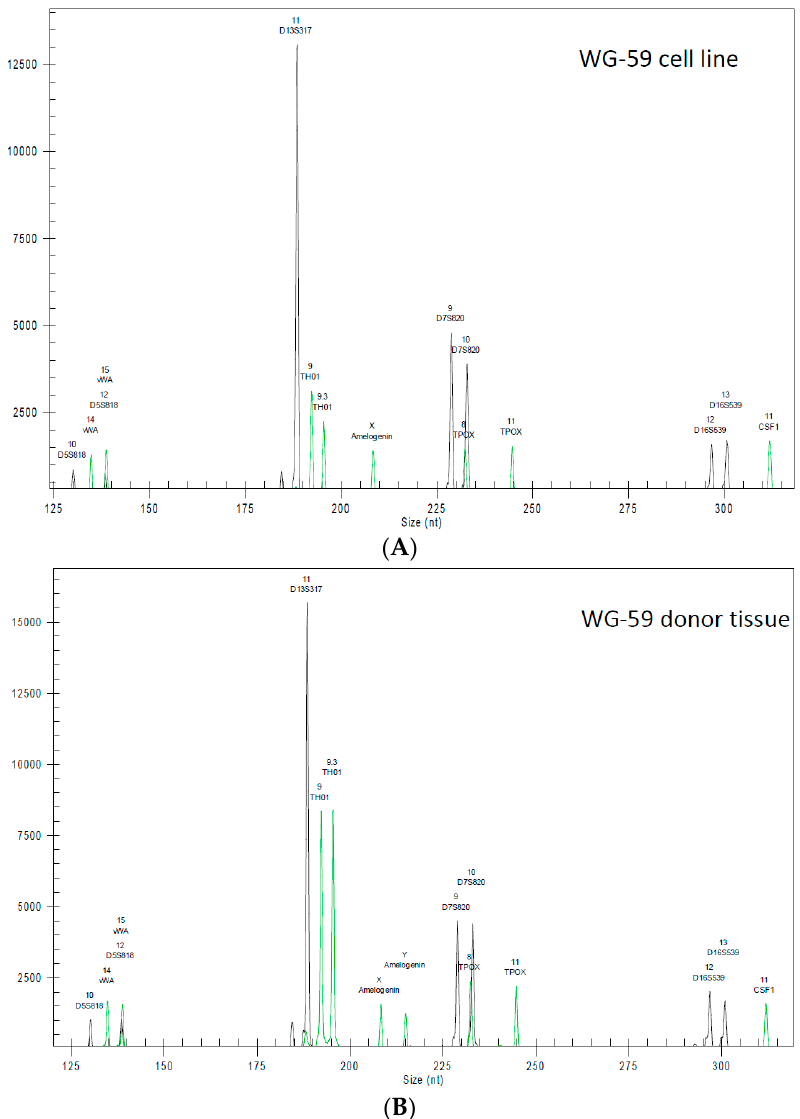
Figure 3. Electropherogram of the short tandem repeat (STR) profiling of ( A ) the WG-59 cell line and ( B ) the WG-59 donor tissue.